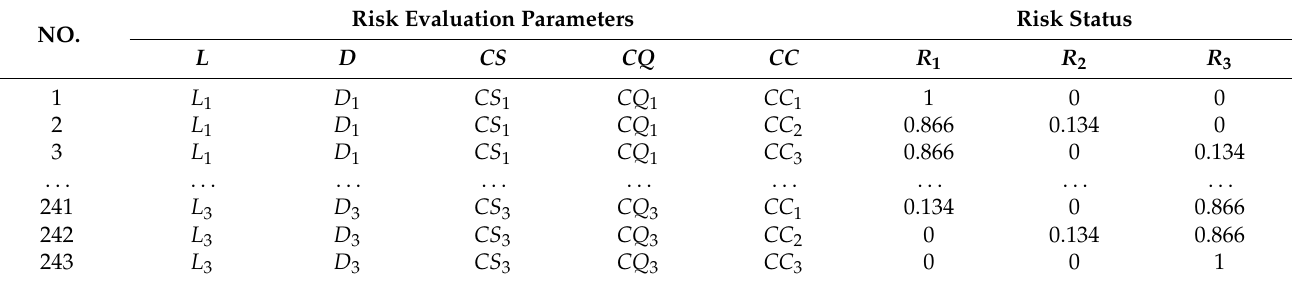
Table 4. FBR with belief structures in